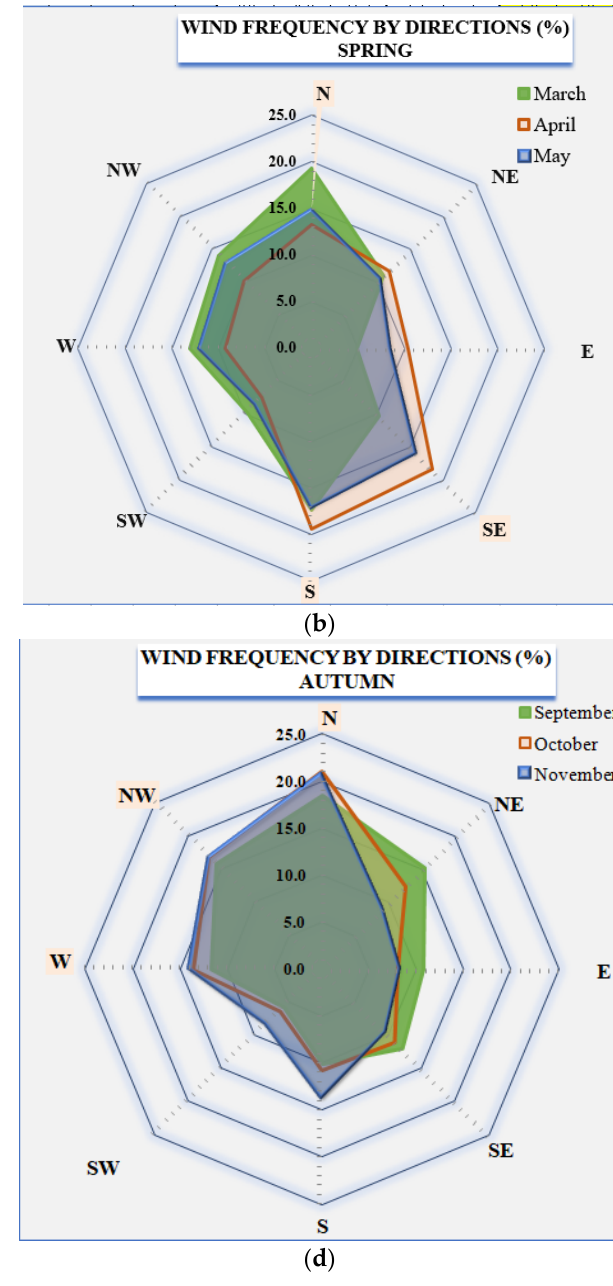
Figure 6. Wind frequency by directions; ( a ) winter; ( b ) spring; ( c ) summer; ( d ) autumn.